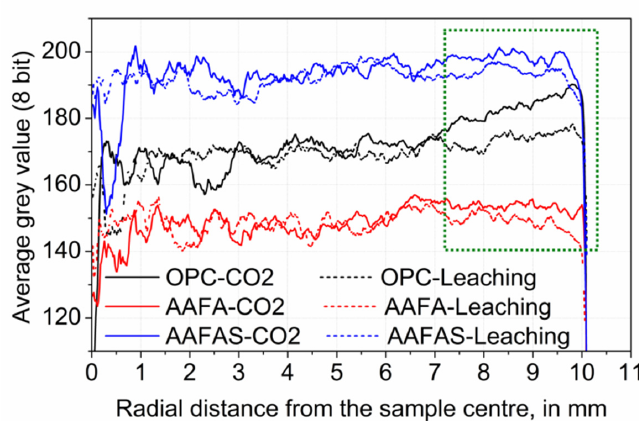
Figure 14. µ XCT images of the cross sections after accelerated CO 2 exposure ( left top ) and leaching Figure 14. µXCT images of the cross sections after accelerated CO 2 exposure (left top) and leaching ( right top ); The graphs show radial plot profiles of > 1000 cross sections referred (by inter standard) (right top); The graphs show radial plot profiles of >1000 cross sections referred (by inter standard) grey values ( down grey values (down).